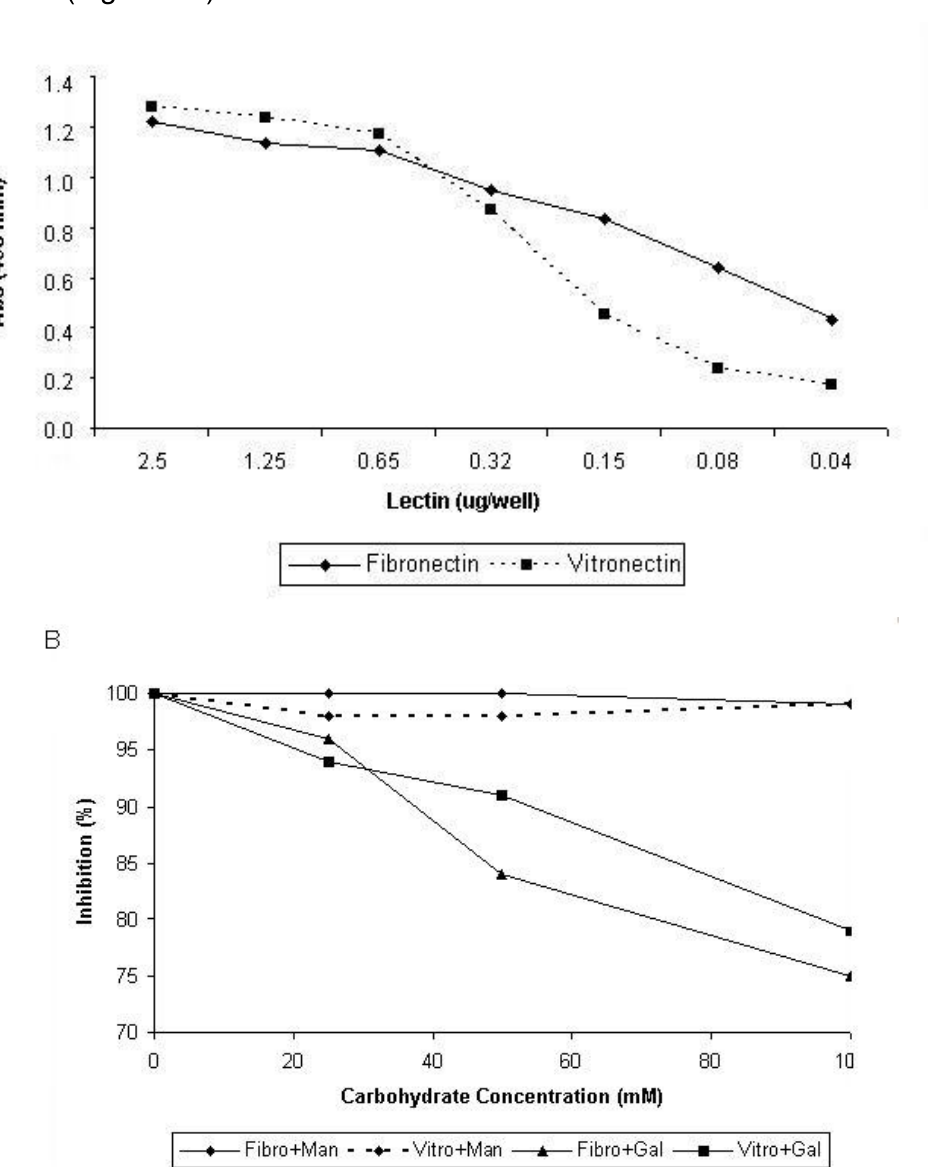
Figure 3. Adhesion of Bothrops jararacussu venom lectin to extracellular matrix proteins, fibronectin and vitronectin (A), and the interference of galactose (Gal) and mannose (Man) at different concentrations (B). Negative control in the absence of